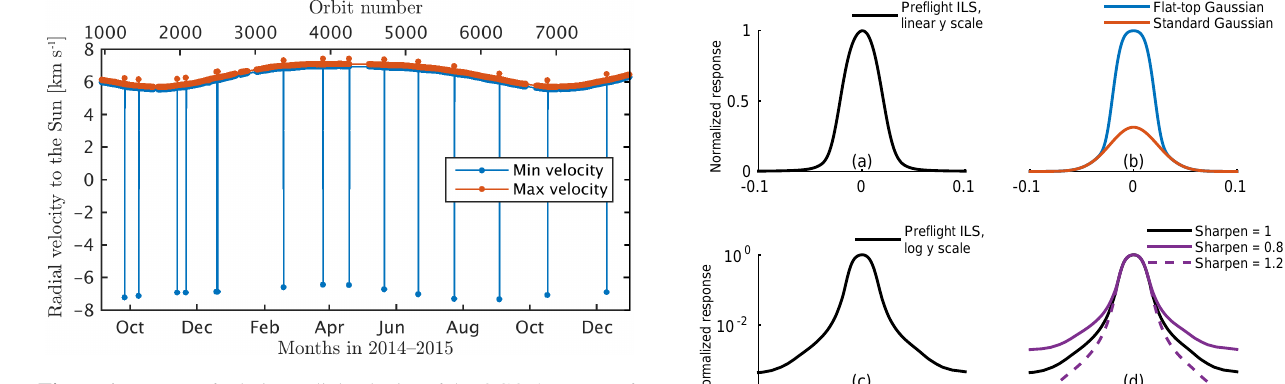
Figure 1. Ranges of relative radial velocity of the OCO-2 spacecraft to the Sun during solar observations. The occasional wide ranges correspond to solar Doppler measurements.